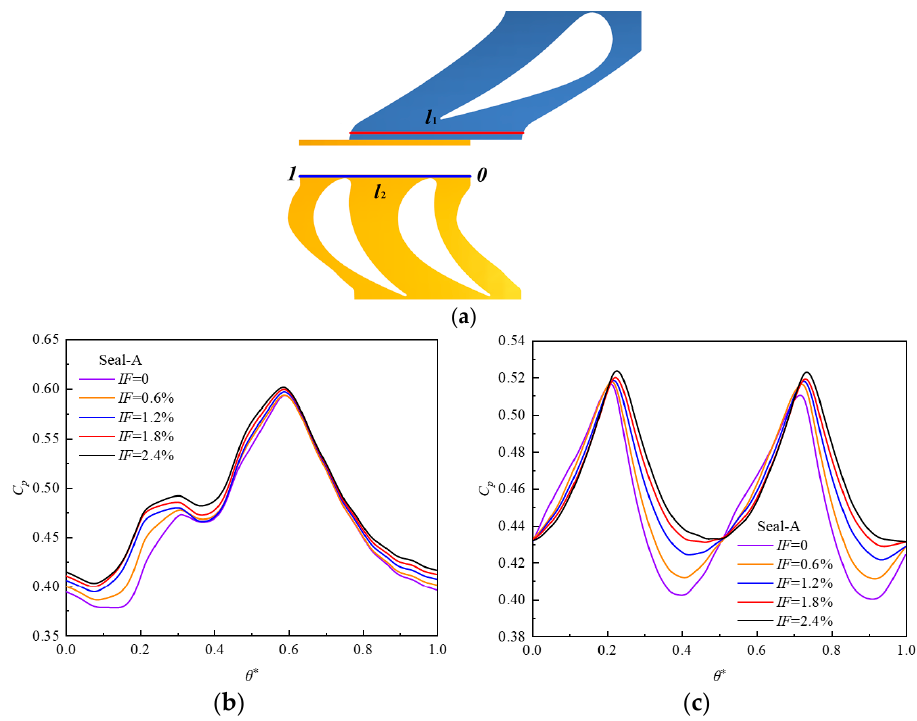
Figure 13. Time-averaged static pressure coefficient C p at the clearance outlet endwall along the circumferential curve: ( a ) position of curves on the vane endwall and the blade endwall; ( b ) vane endwall; ( c ) blade endwall.